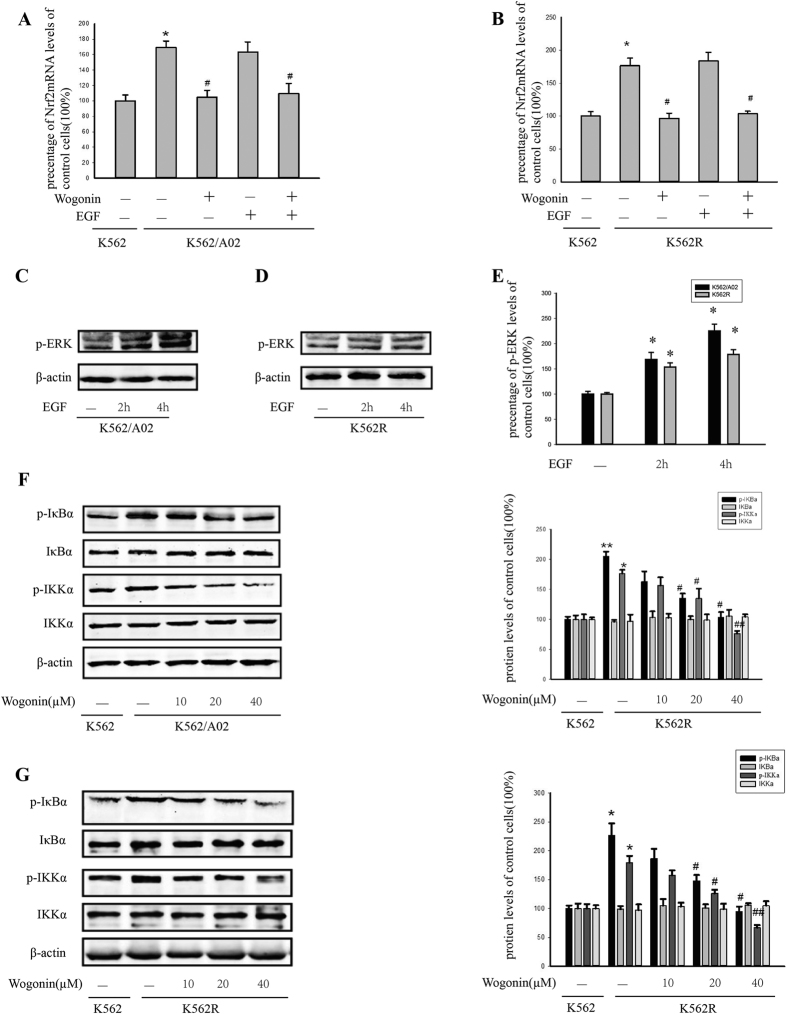
Wogonin decreased p-IKKα and p-IκBα.(A,B) K562/A02 and K562R cells were pretreated with 50ng/ml EGF for 4 h and then treated with or without 40 μM Wogonin for 24 h. Levels of Nrf2 mRNA in treated K562, K562/A02 and K562R cells were determined by RT-PCR. *p < 0.05 versus untreated K562 cells. #p < 0.05 versus untreated K562/A02 or K562R cells. (C,D) K562/A02 and K562R cells were treated with 50ng/ml EGF for 2 h and 4 h. The expression of the downstream gene p-ERK was detected by Western blot in treated cells. (E) The expression of p-ERK was analyzed at 2 h and 4 h after treatment with 50ng/ml EGF. *p < 0.05 versus untreated K562/A02 or K562R cells. (F,G) K562/A02 and K562R cells were exposed to various concentrations of Wogonin (10, 20, and 40 μM) for 24 h. p-IkBα/IkBα and p-IKKα/IKKα was analyzed by Western blot analysis. *p < 0.05 versus untreated K562 cells. #p < 0.05 versus untreated K562/A02 or K562R cells. All results were represented as the mean ± SD of three independent experiments.